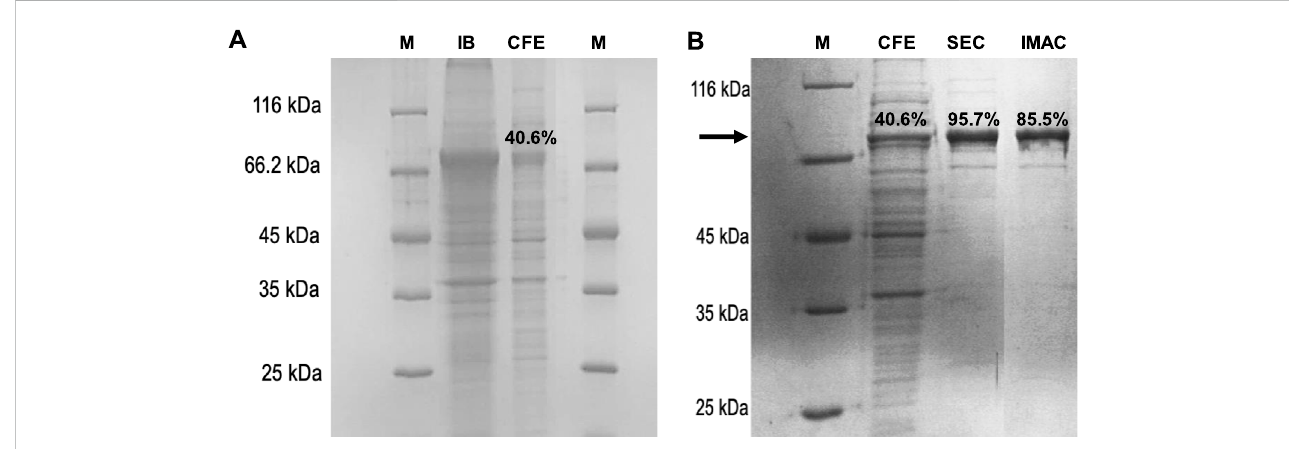
FIGURE 3 SDS-PAGE analysis of (A) PAPSS1 overexpression in transformed E. coli BL21 (DE3) cells: M, molecular weight marker; IB: insoluble protein fraction (inclusion body), CFE, soluble protein fraction, and (B) PAPSS1 puri fi cation by IMAC and size exclusion chromatography (SEC).